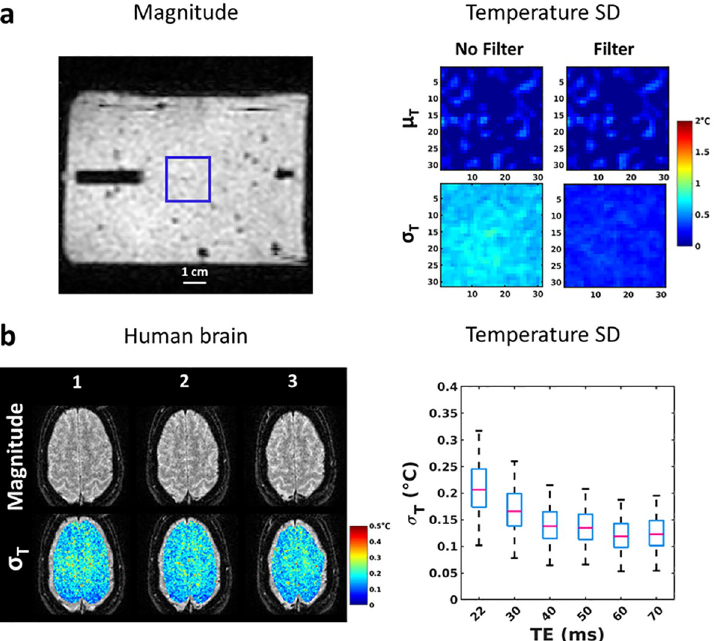
Fig 2. Temperature precision in gel and in human brain. (a) Left: Magnitude image of the thermometry sequence. The overlaid blue square delimits the region where the analysis of temperature data was performed. Horizontal bar represents 1 cm. Right: Maps of μ T and σ T computed over the complete time series before and after filtering with a Butterworth low-pass filter. Mean ± SD of μ T and σ T were 0.00 ± 0.2˚C and 0.65 ± 0.05˚C before filtering and 0.00 ± 0.2˚C and 0.21 ± 0.04˚C after filtering, respectively. (b) Left: Measurement of the temperature standard deviation over the brain of a healthy volunteer. Images on the left show the magnitude images (top row) averaged over 10 consecutive acquisitions and temporal standard deviation of temperature ( σ T , bottom row) for a TE of 30 ms in a large ROI covering the brain. Right: Box and whiskers plots show the distribution of σ T for different TE within the ROI. Median values are displayed in pink and box correspond to 25% (bottom of the blue box) and 75% (top of the blue box) of the distribution, while the upper limit of the whiskers corresponds to 95% of the pixels in the ROI.